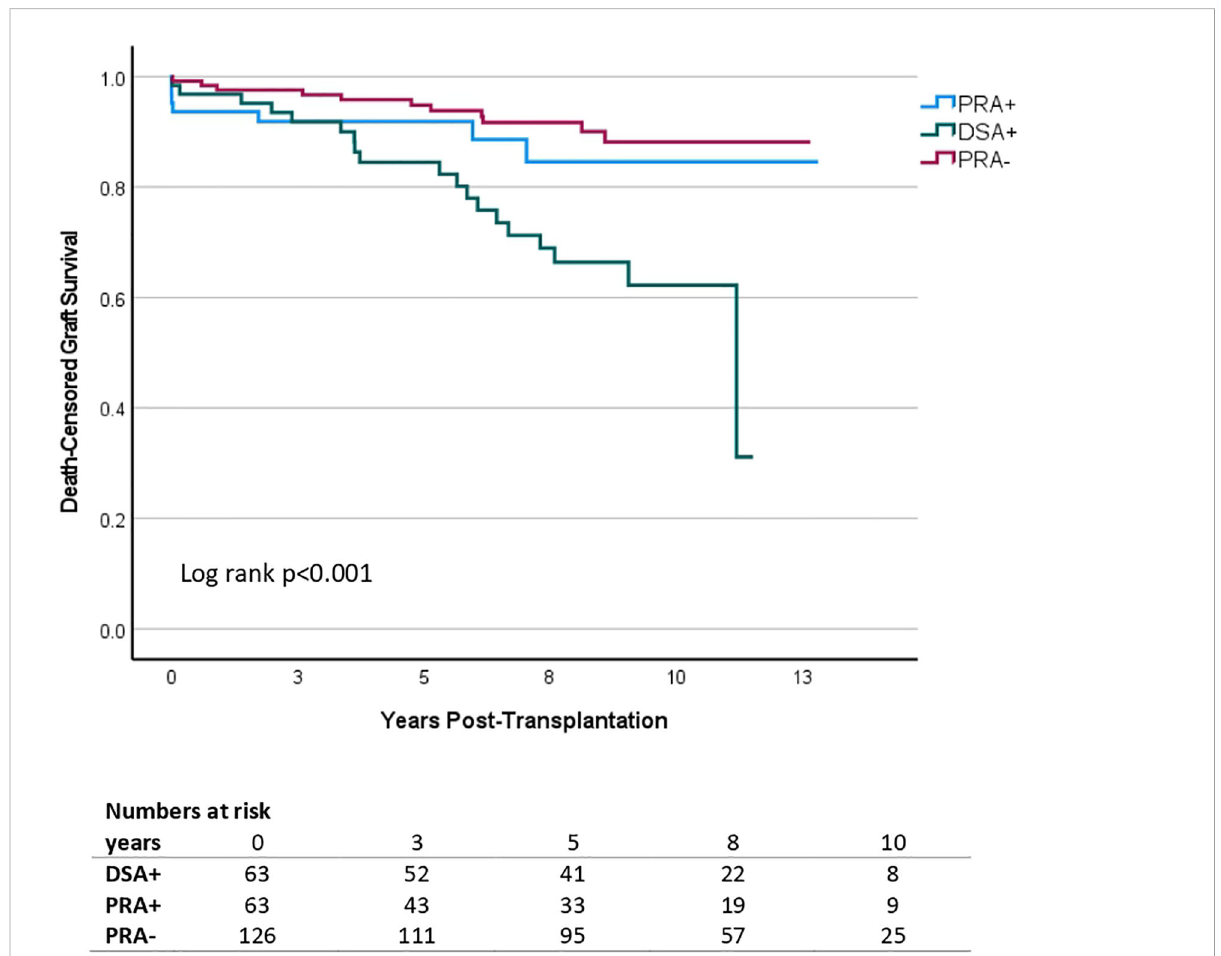
FIGURE 1 Kaplan Meier survival analysis of death-censored graft survival in living donor kidney transplantation according to the presence and type of pre- transplant anti-HLA antibodies. Patients with donor-speci fi c antibodies (DSA+) were matched to equally immunized controls without DSA (PRA +) and non-immunized controls (PRA-). Additional matching variables were transplantation year, age of donor and recipient and donor-recipient relation. DSA+ (n=63) is depicted in green, PRA+ (n=63) in blue and PRA- (n=126) in red. The y-axis represents the proportion of individuals without graft failure, censored for death. The x-axis represents the time from transplantation in